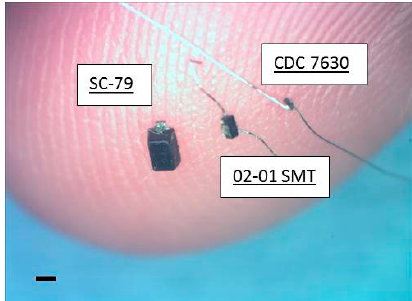
Figure 1. Pictures of the modified Skyworks 7630 diodes placed on an adult (digit 5) finger that were used for wireless neuromodulation. Images of the mini- and micro-diodes are prior to lead trimming and subsequent implantation into the peripheral nerve. The mini-diode is capable of placement under the epineurium, while the micro-diode is capable of both subepineurial and deep nerve tissue placement. Scale bar is 0.5 mm.